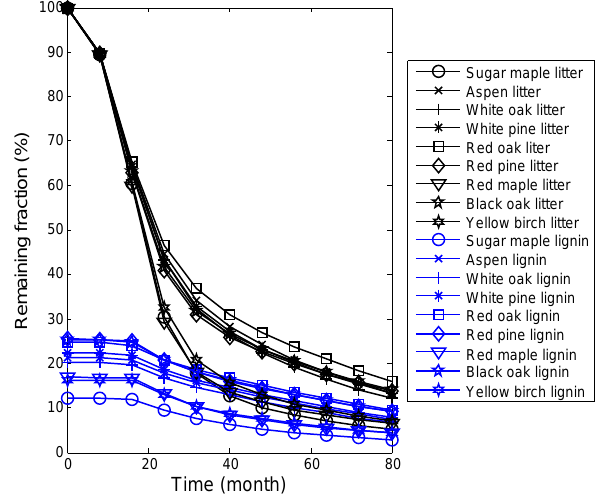
Fig. 16. Model (S3B3-ECA) predicted temporal patterns of total litter and lignin degradation for the 9 different litter